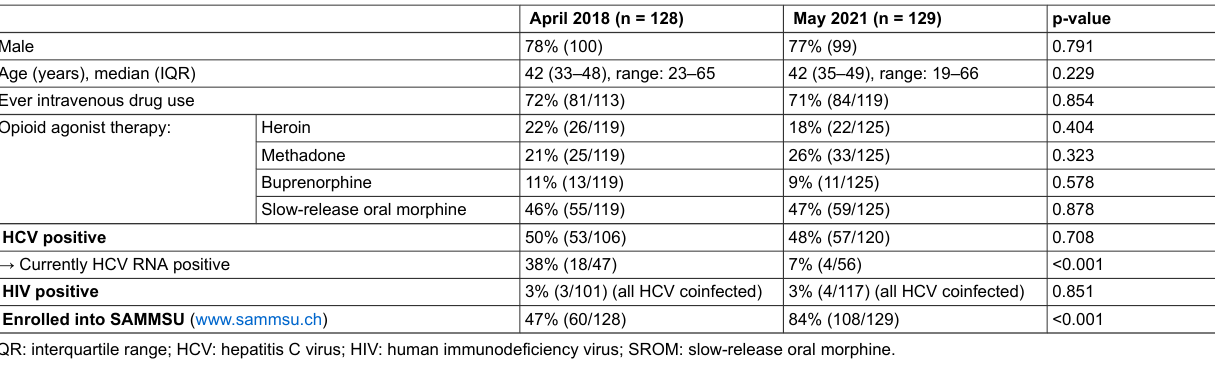
Table 1: Patient